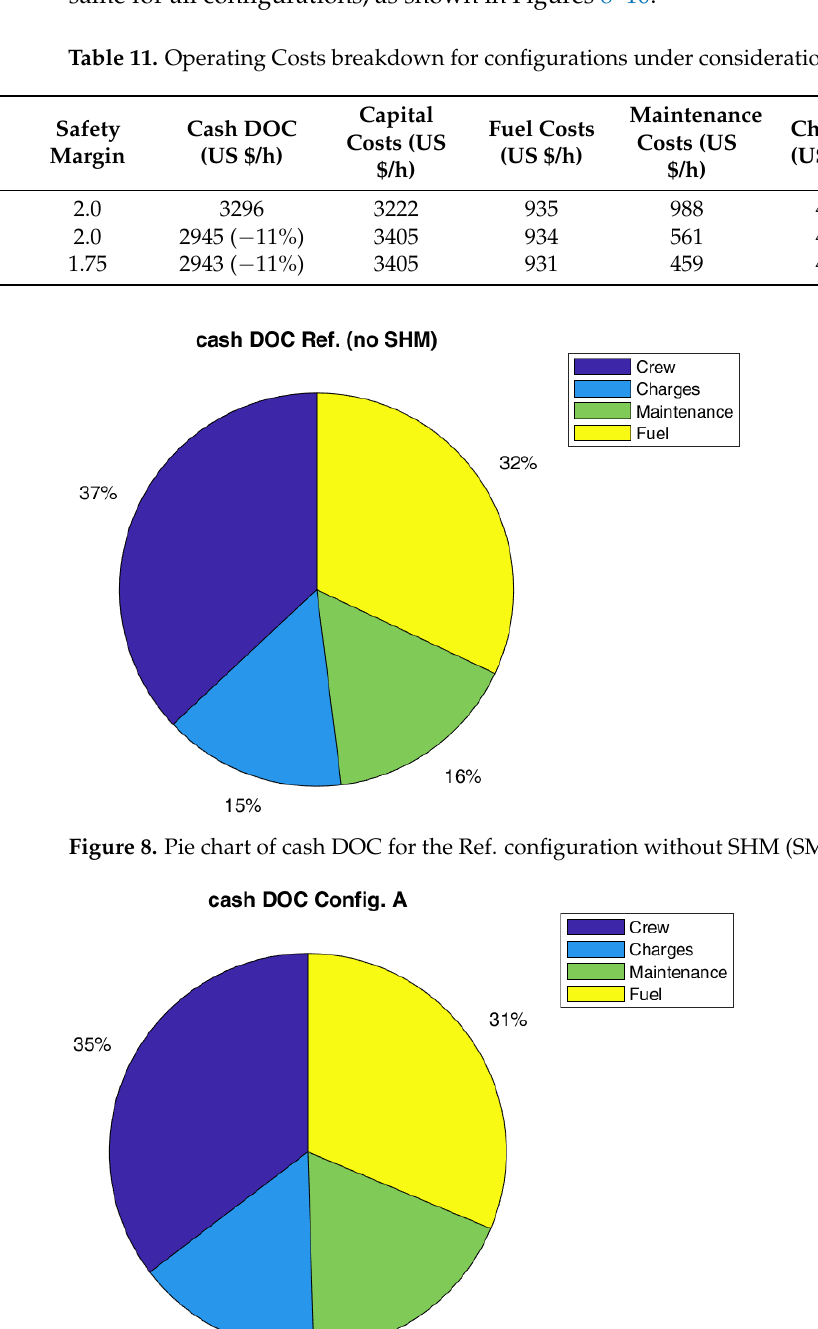
Figure 10. Pie chart of cash DOC for Config. B (SM = 1.75, with SHM). In order to obtain a greater effect in terms of direct operating costs, it has been inves- tigated also the configuration with a lower value of sensors density, equal to 10 sensors per square meters, and designed with a lower value of safety margin, equal to 1.75, named configuration C. Again, the investigation based on this assumption could be considered as trend analysis, since the best density was unknow as already stated above and it strongly depends on the technology level of the SHM system. As already done for other